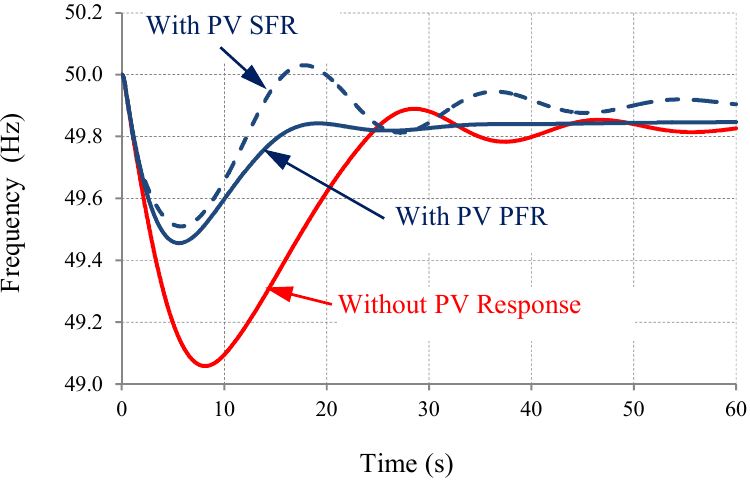
Figure 10. System frequency response to 350 MW generator trip, at minimum Residual Load point of the year 2030, Case 1.